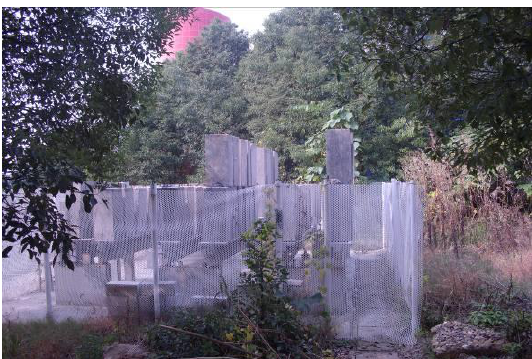
Figure 2. Size and reinforcement of T-beam (unit: mm): ( a ) mid-span section and ( b ) fulcrum cross- section.